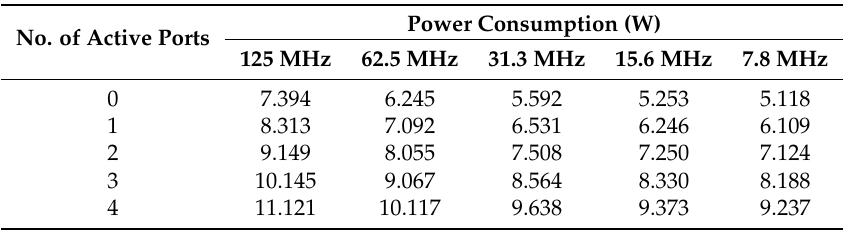
Table 4. Impact of operating frequency and the number of active ports on power consumption of the